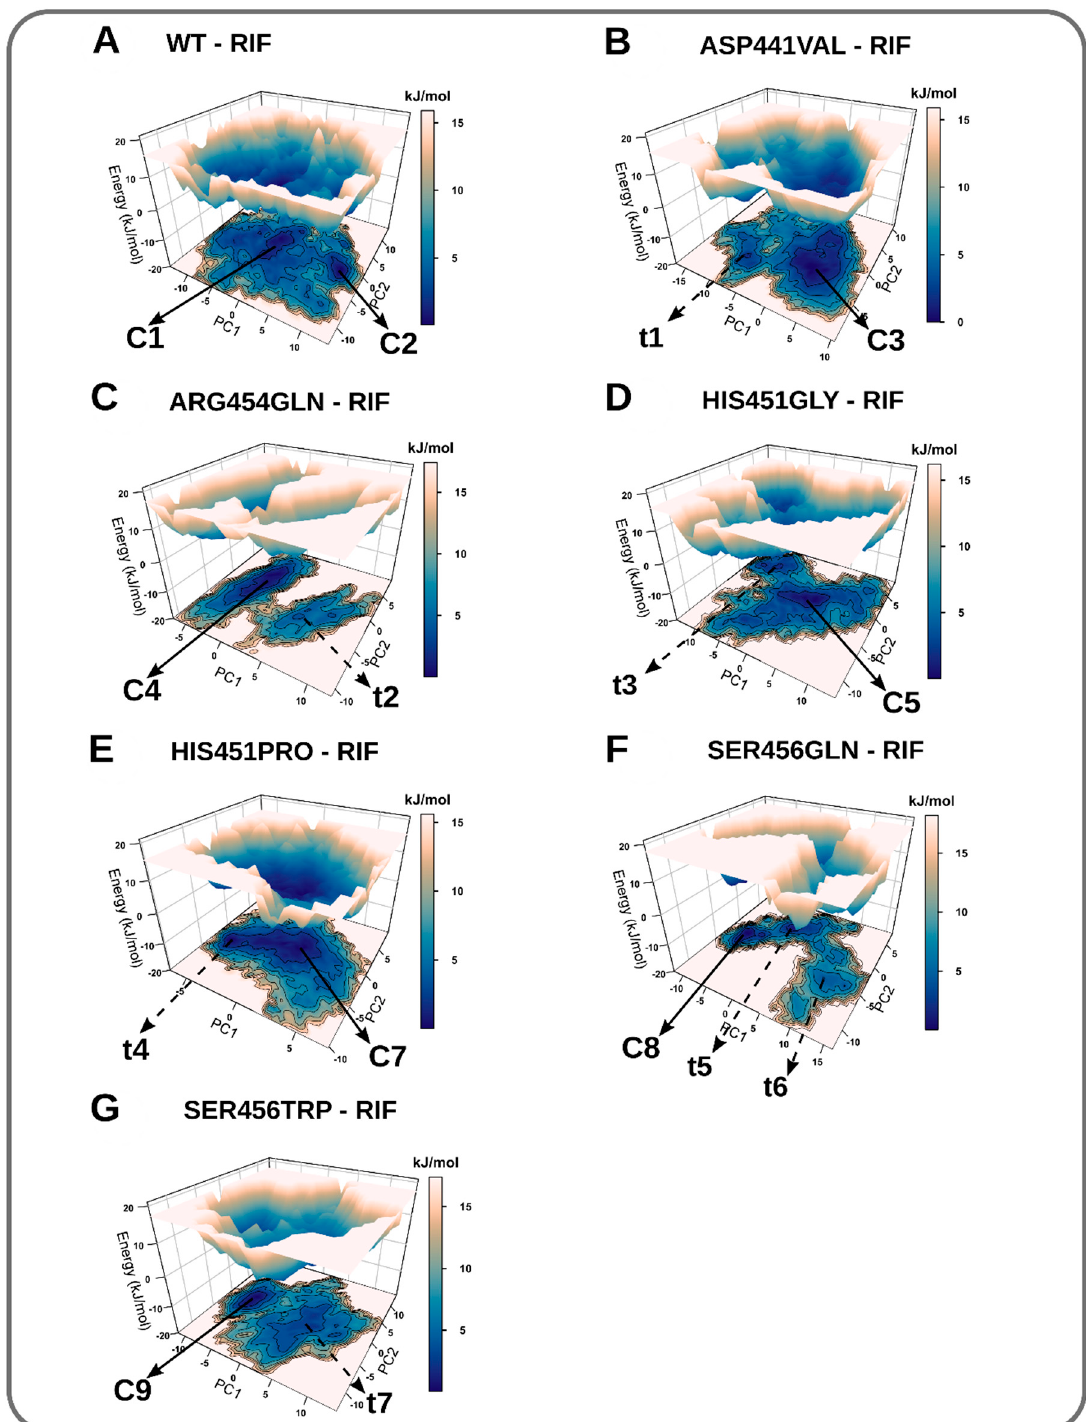
Figure 5. Protein free energy landscapes computed as a function of PC1 and PC2 for WT and mutated systems. Color ranges from white (energy maxima) to blue (energy minima). Labels: c: conformers, t: transition substates.